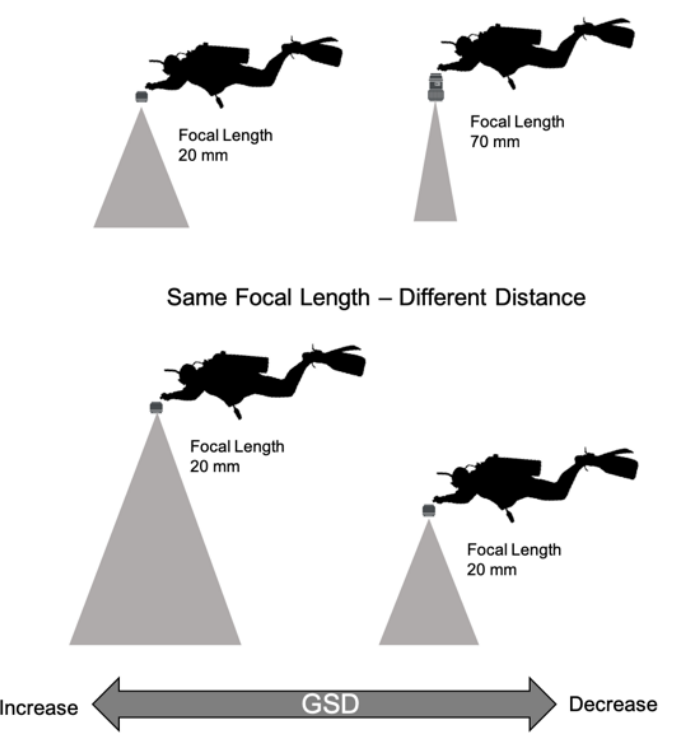
Figure 15. Diagram illustrating the effect on GSD of varying either the focal length or the distance between the camera and the substrate.